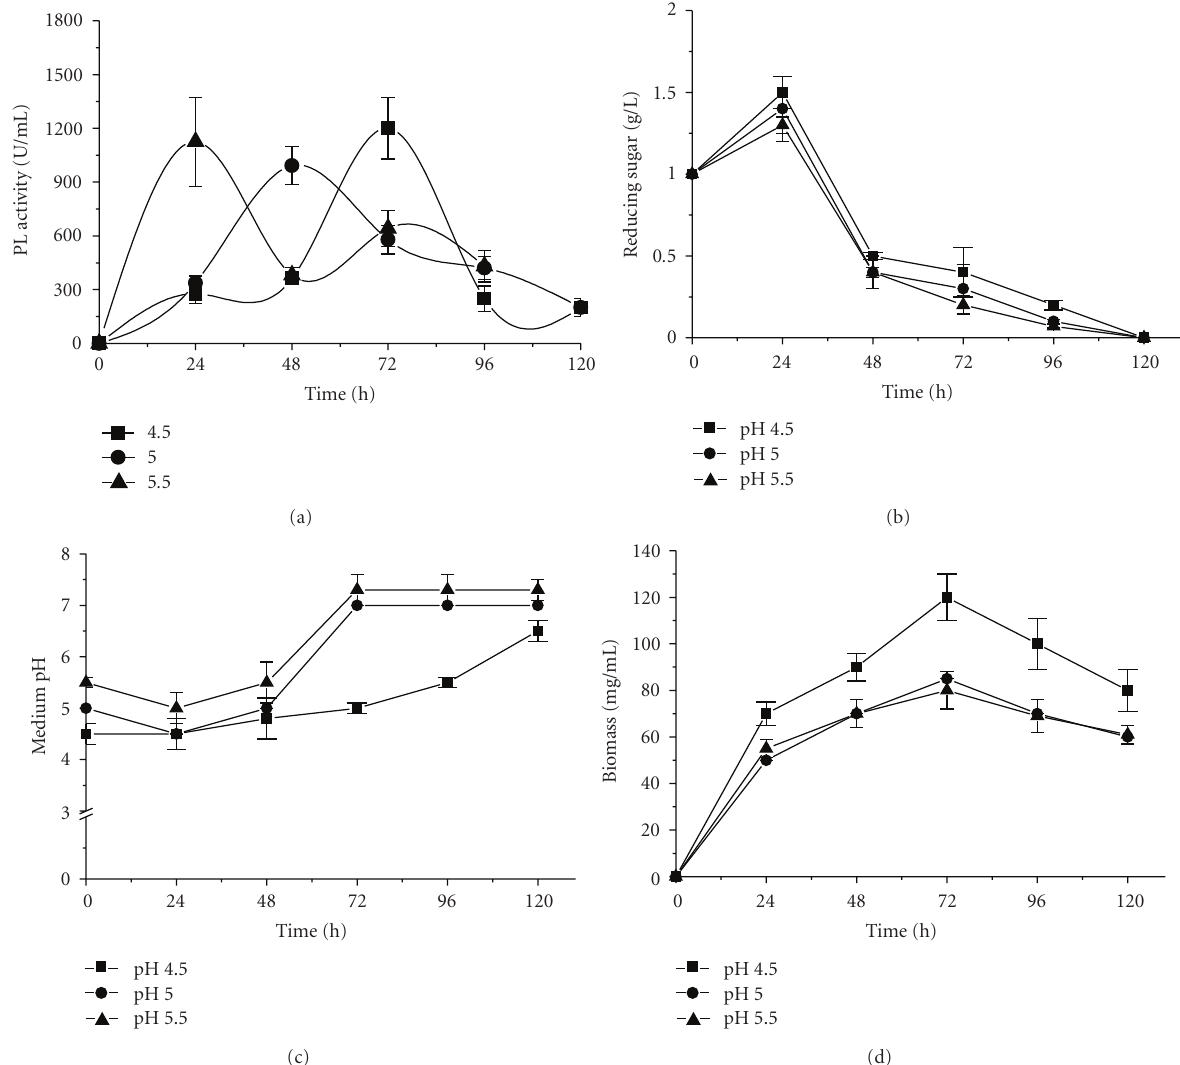
Figure 2: PL production by P. viridicatum RFC3 in submerged fermentation (SmF), using wheat bran and orange bagasse (1:1) as carbon source. (a) PL activity; (b) reducing sugar; (c) medium pH; and (d) biomass production. ( ) = pH 4.5;( ) = pH 5.0; and ( ) = pH 5.5.